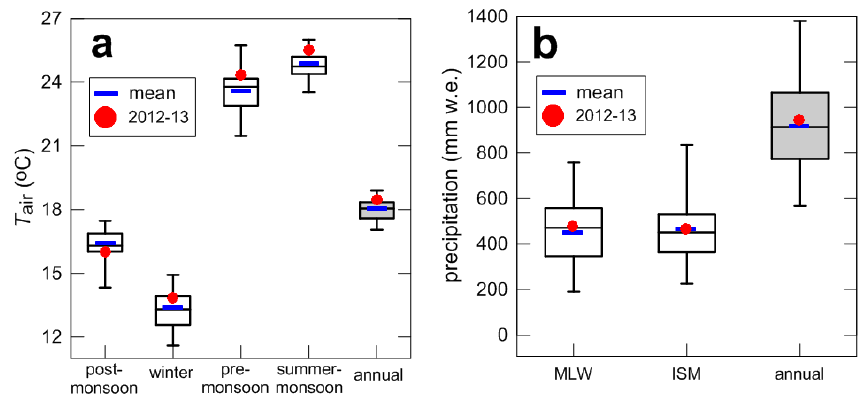
Figure 6. Boxplots of seasonal and annual T air (a) and precipitation (b) obtained from 44 hydrological years (1969 to 2013) from Bhuntar meteorological station. Boxes cover the 25th to the 75th percentile of each distribution with a central line as the median. The blue thick horizontal line is the 1969–2013 mean, red dot is the 2012/2013 hydrological year